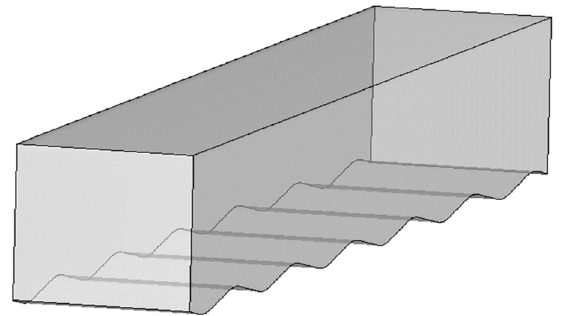
Figure 4. Outline of computational domain with wavy wall.